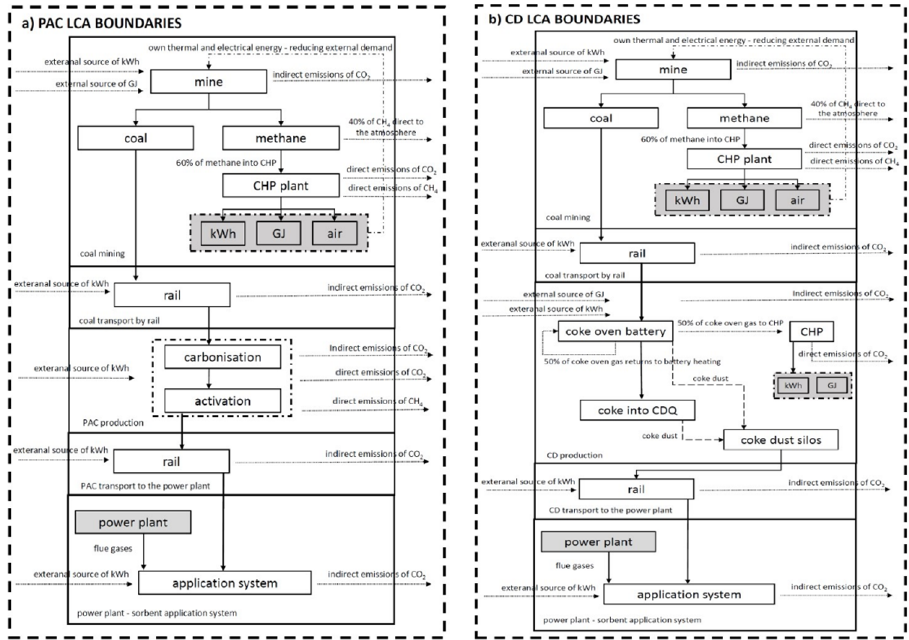
Figure 1. System boundaries for CF analysis of sorbent production and application: ( a ) PAC and ( b ) CD.